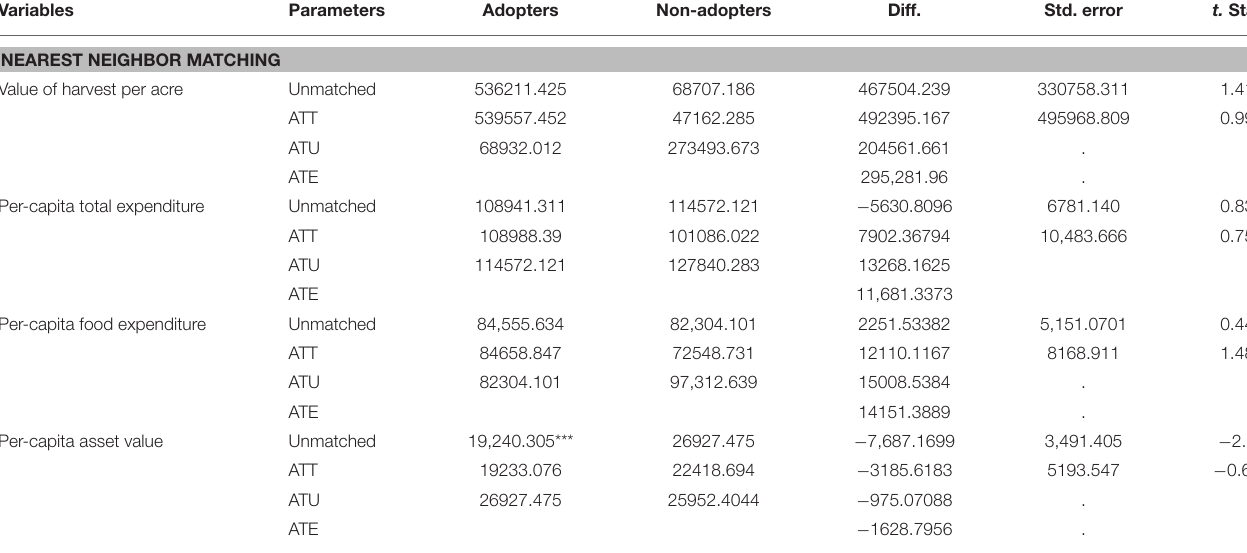
TABLE 4 | Propensity score matching: welfare impact of adoption of organic fertilizers. Variables Parameters Adopters Non-adopters Diff. Std.